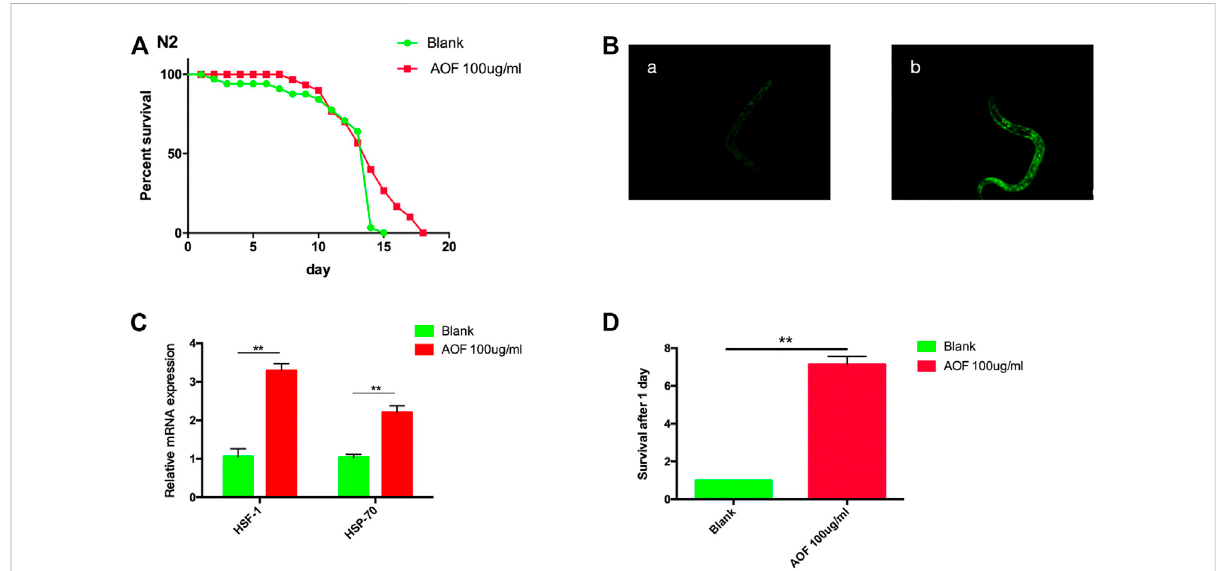
FIGURE 6 Effect of AOF treatment on (C) elegans N2. (A) heat-shock survival at 35 ° C, and (B) a representative image of the nuclear HSF-1:GFP fraction in (A) ,Blankgroupand (B) ,100 μ g/mlAOFgroup,and (C) thetranscriptionallevelsofhsf-1 、 hsp-70,and (D) paraquat-inducedoxidativestresssurvival. Data are the mean ± SD ( n = 3). ** p < 0.01